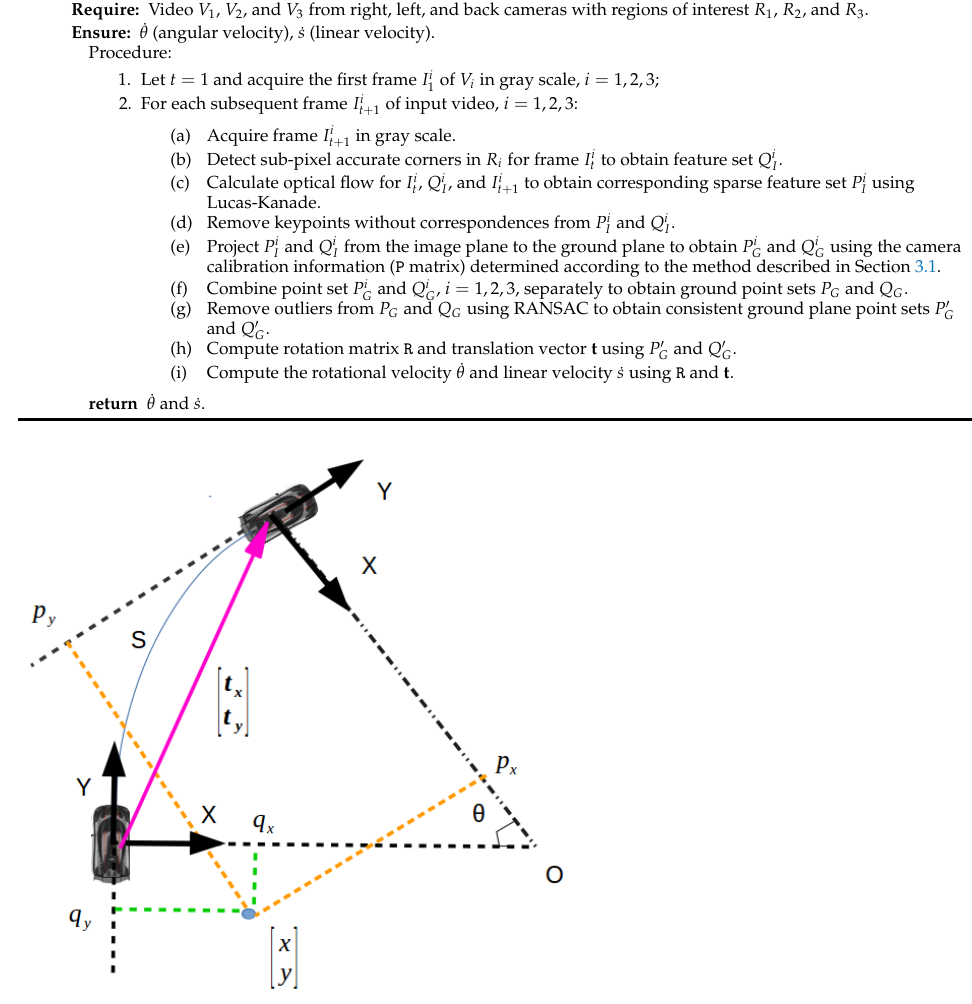
Algorithm 1: Velocity from Optical Flow.